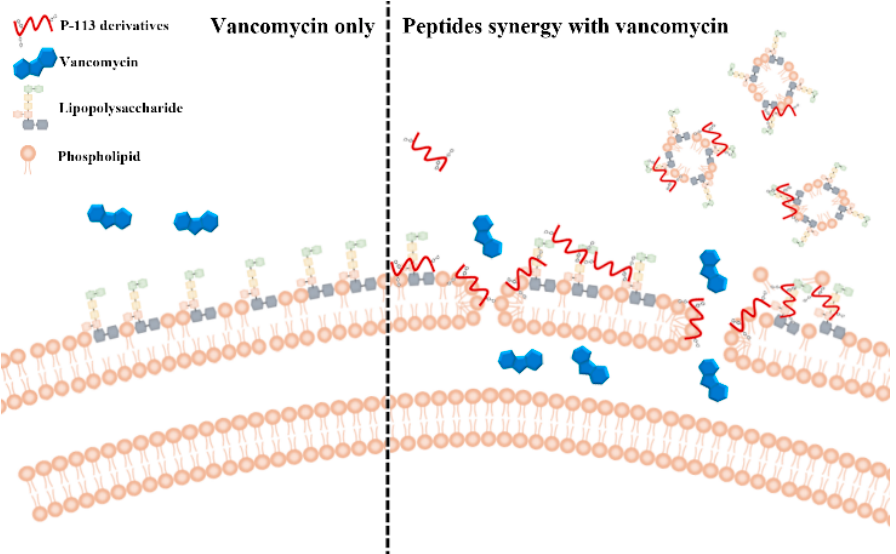
Figure 6. Synergistic mechanism of action proposed for P-113 derivatives and vancomycin. For vancomycin, the efficacy was limited due to the permeability barrier of the outer membrane of Gram- negative bacteria (left panel). However, P-113 derivatives (e.g., Bip-P-113, Dip-P-113, and Nal-P-113) could disturb the outer membrane of Gram-negative bacteria and enhance the entry of vancomycin